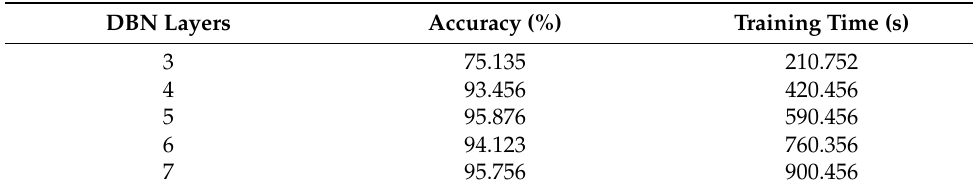
Table 3. Deep Belief Net (DBN) layers and